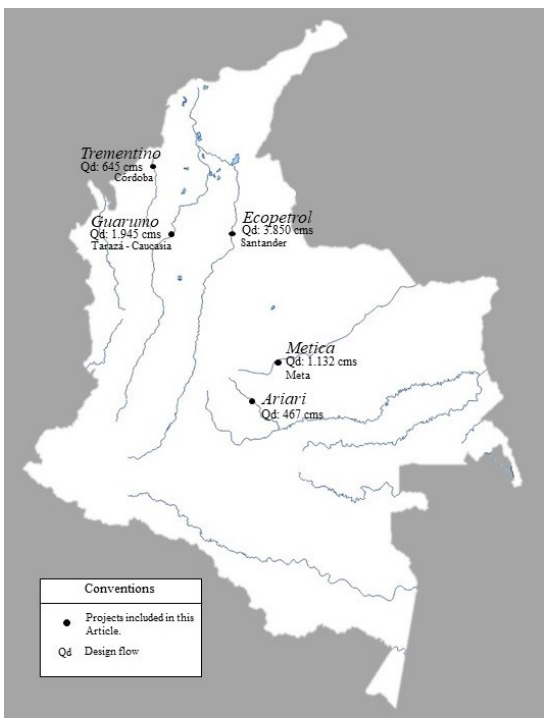
Figure 1. Location of the five projects with submerged vanes mentioned in this article.